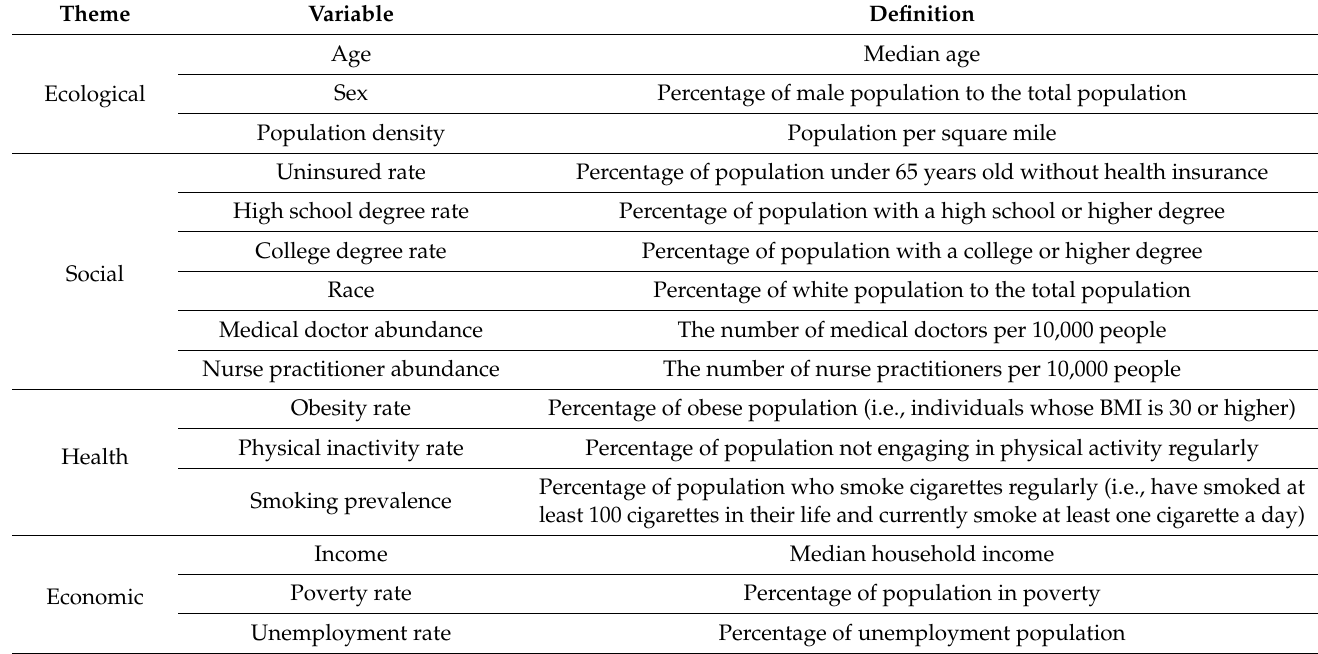
Table 1. Candidate explanatory variables and